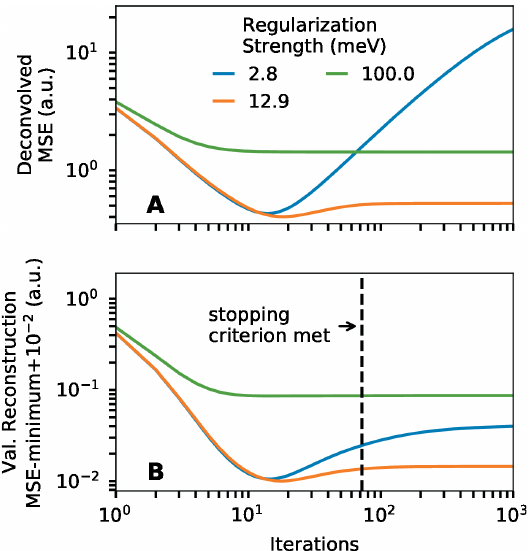
Figure 5 Illustration of the stopping criterion for the same data set as Fig. 3(A). (A) Dependence of the deconvolved mean squared error (MSE) on iteration number and regularization strength. (B) Dependence of MSE of the reconstruction of validation data on iterations. The stopping criterion is four times the number of iterations required for the validation error to reach a minimum with the smallest tested regularization strength.